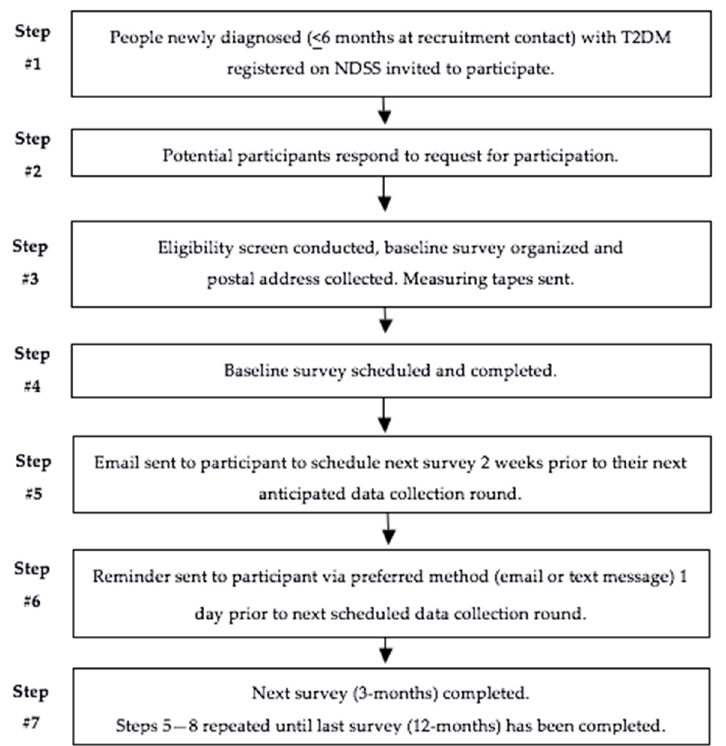
Figure 1. Recruitment and contact process for the 3D Longitudinal Study.